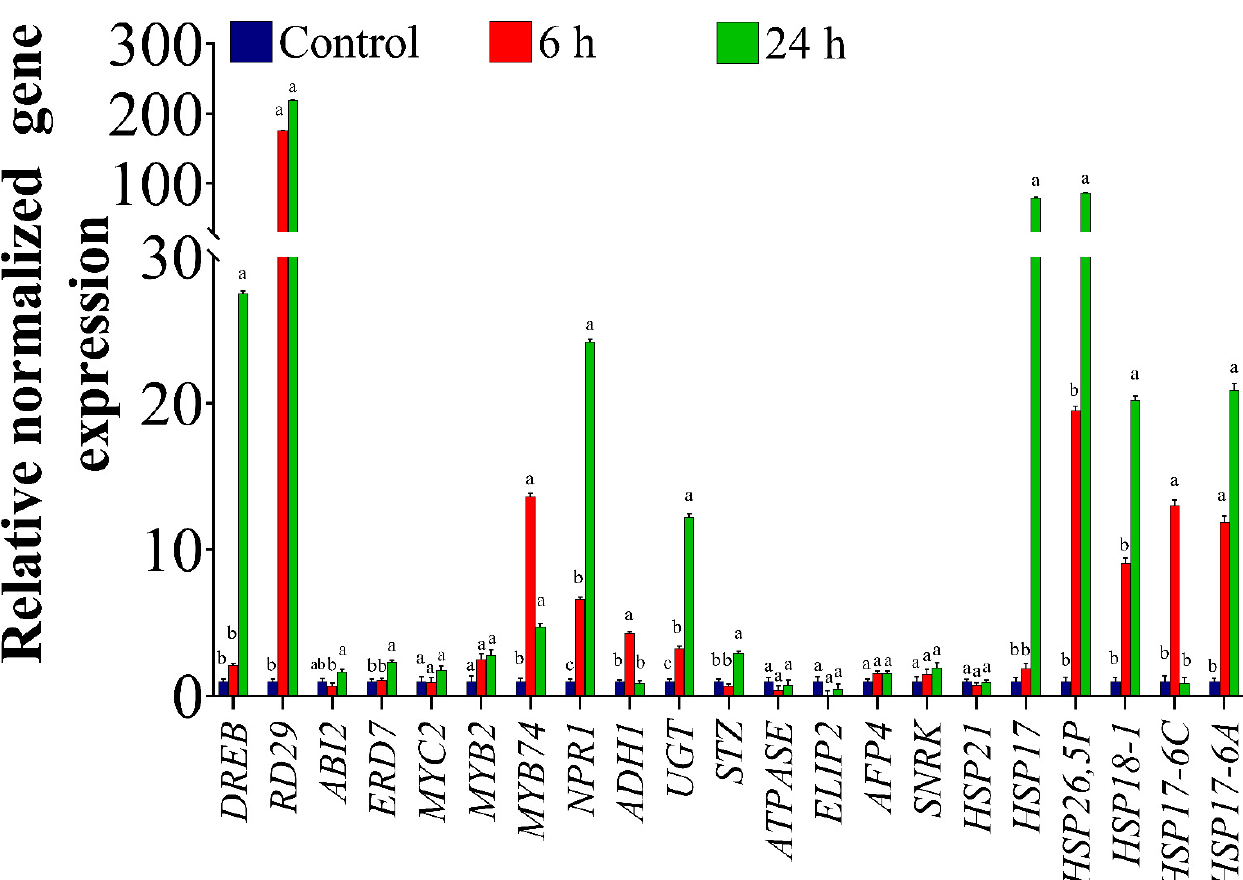
Figure 1. Expression of ORGs genes in homografted potatoes ( Solanum tuberosum ), assessed by qRT-PCR. Plants were osmotically stressed by watering with 30% PEG four weeks after graft establishment. Tissues located 5 cm above the graft union were collected from untreated plants (control) and PEG-treated plants at 6 h and 24 h of treatment. The bars show the normalized relative expression of potato ORGs. The gene expression values were calculated relative to homografted potato control (P/P) and normalized to TIP , an internal control. The bars represent the means ± SEM of three biological replicates. Different letters in the graph indicate significant differences ( p < 0.05) in relative gene expression between treatments after Tukey’s test.